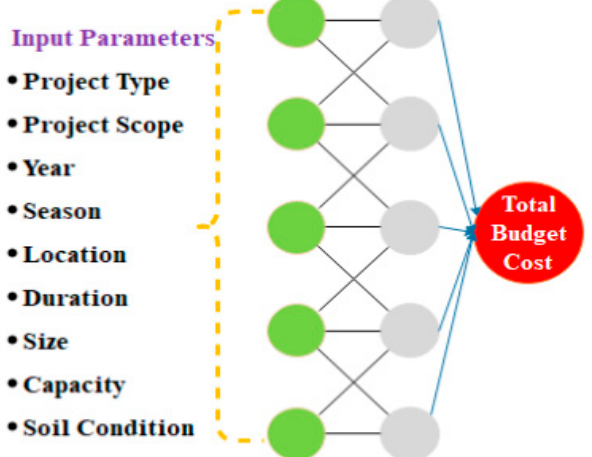
Figure 9. Neural network for prediction of the budget cost of a project.